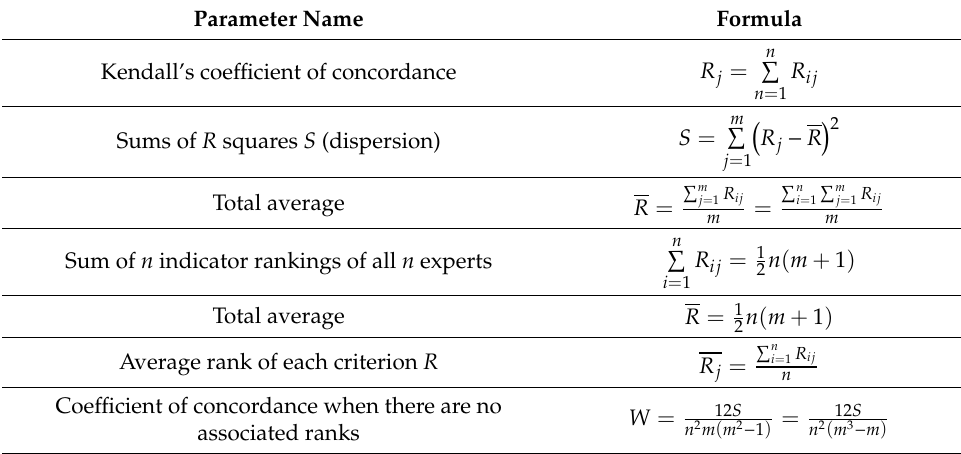
Table 2. Dependencies necessary for carrying out an expert